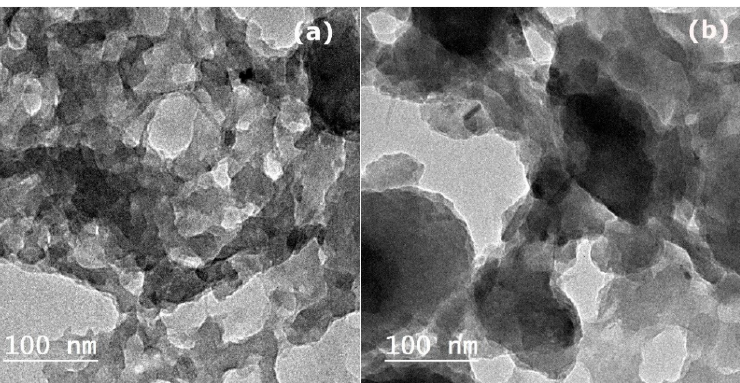
Figure 2. ( a ) TEM images of hydrochar (HC) after the microwave-assisted hydrothermal carbonization treatment and ( b ) activated hydrochar (AHC) after the microwave-assisted hydrothermal carbonization treatment and chemical activation by ZnCl 2 .